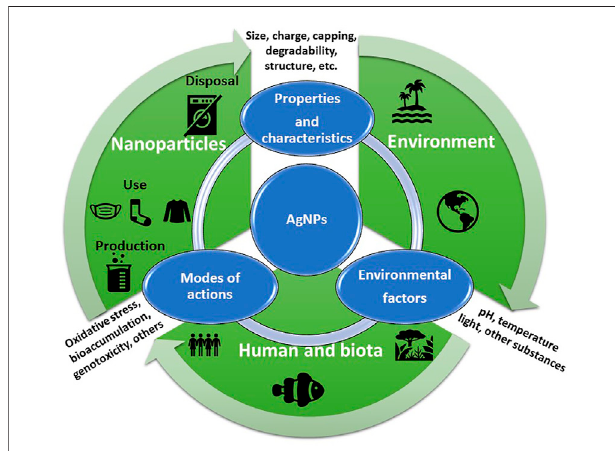
FIGURE 4 | Schematic representation of the production, use, disposal, fate, and effect of AgNPs as well as the main parameters affecting the toxicity mechanisms of